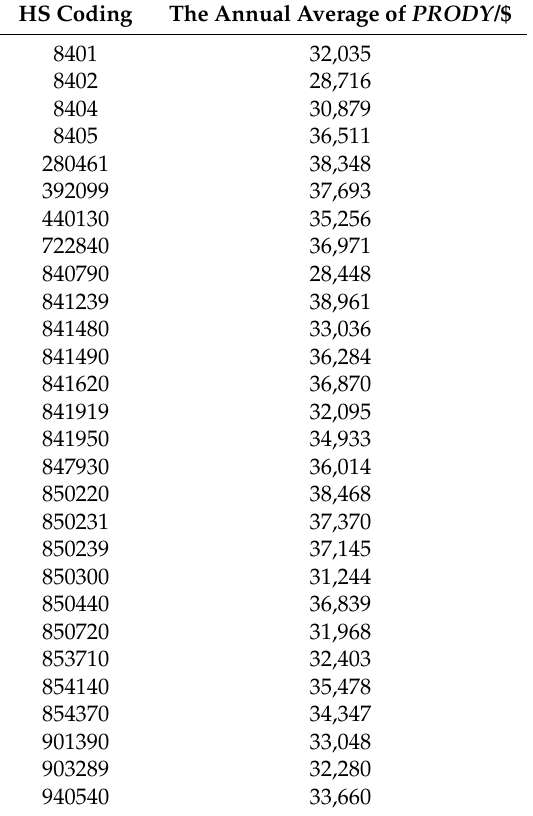
Table A3. The annual average of PRODY for REPs from 2007 to 2016. HS